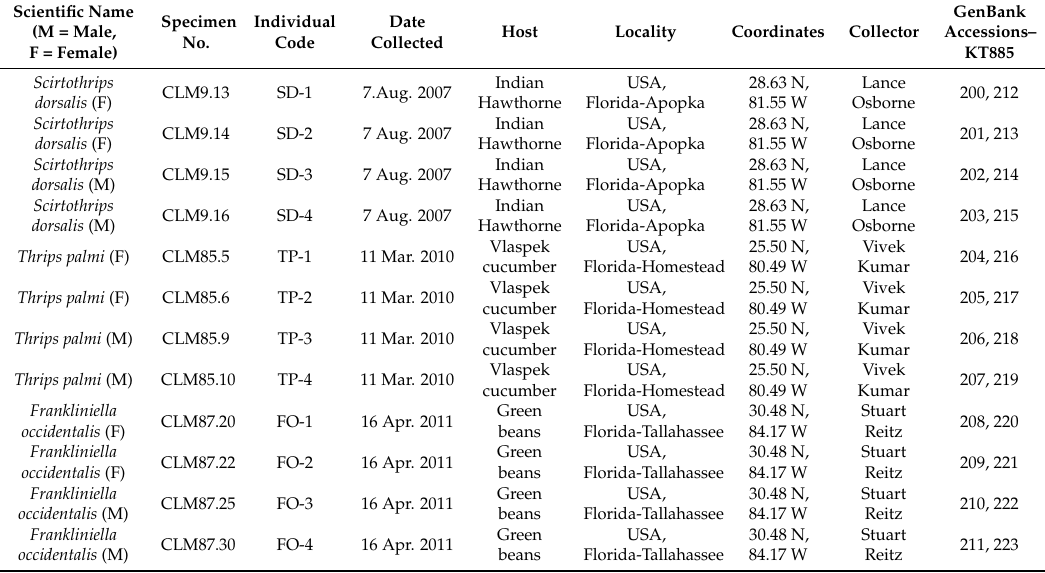
Table A1. Collection date, localities and hosts for specimens used in cloning of rDNA and mtCO1 genes of thrips species of three genera.